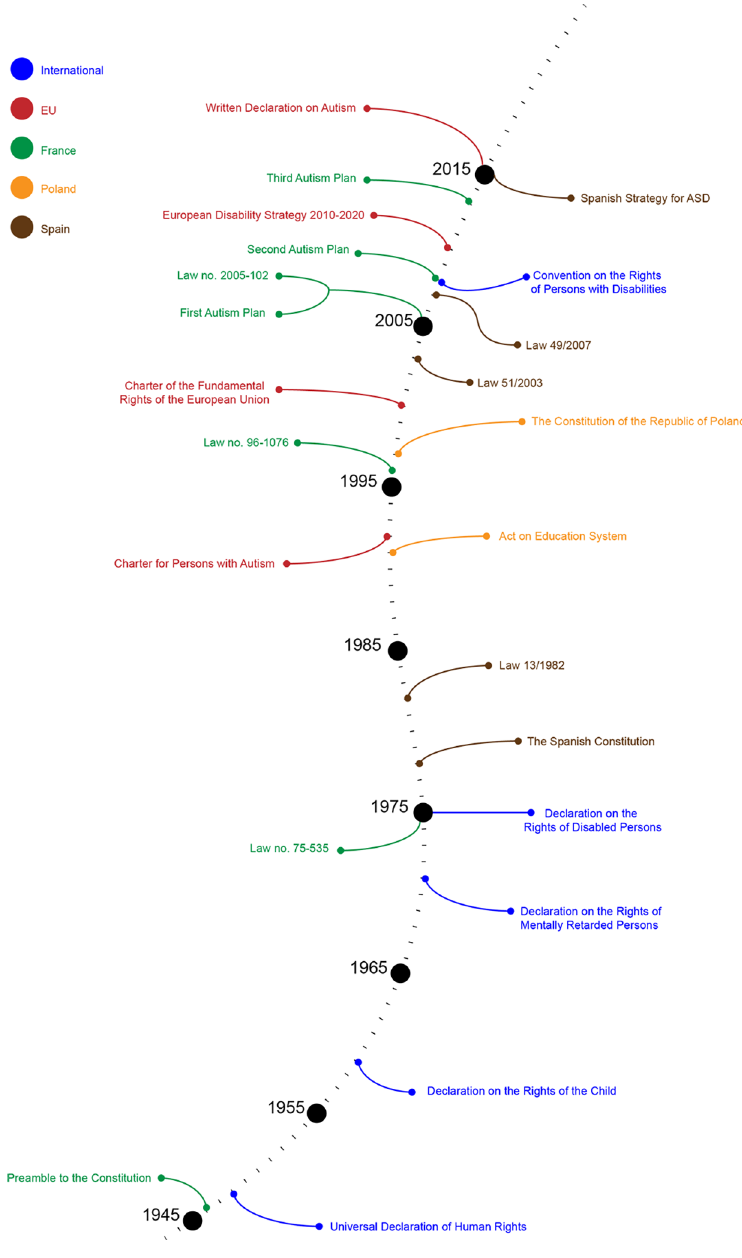
Fig 2. An overview of international, EU, French, Polish, and Spanish policies on SEN and